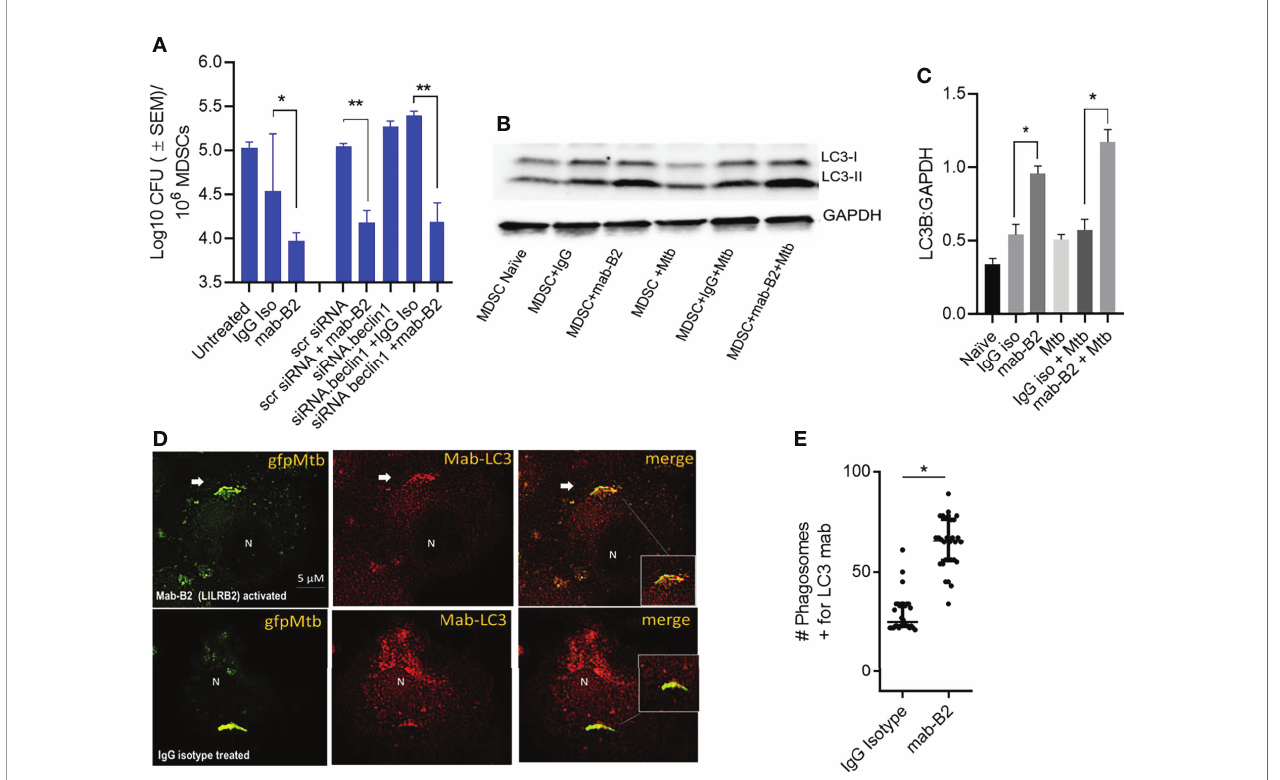
FIGURE 3 | LILRB2 antagonism effects on the bactericidal function of the MDSCs are independent of autophagy. (A) CD14 + /CD33 + bead-puri fi ed M-MDSCs derived from GM-CSF/IL-6 cultured PBMCs from donors were subjected to autophagy blockade using siRNA vs. beclin1 ( ATG6 ) or its scrambled control, followed by infection with Mtb H37Rv (MOI = 1), washed, and incubated after activation with mab-B2 or isotype. MDSC lysates were plated on day 3 for Mtb CFUs on 7H11 agar (triplicate wells per point; p < 0.008, 1-way ANOVA and Tukey ’ s posttest; 1 of 2 similar experiments shown). (B) Lysates of cells from panel A were collected at 18 h and analyzed using Western blot for the autophagy marker, microtublue-associated light chain-3 (LC3). Lipidation is indicated by LC3-II. (C) Densitometry of cells from panel B indicates the expression of LC3 normalized to GAPDH. (* p < 0.01 t -test). (D) M-MDSCs were infected with gfp Mtb (4 h MOI = 1) followed by fi xation in 3.7% paraformadehyde and staining using mab to LC3 followed by Alexa fl uor590 anti-IgG conjugate. Images were acquired using an N90 Nikon scope with Metaview deconvolution software. (E) Data show quantitation of gfp Mtb phagosomes colocalizing with mab-LC3 staining (* p < 0.05, ** p < 0.005, t -test; 1 of 2 similar experiments